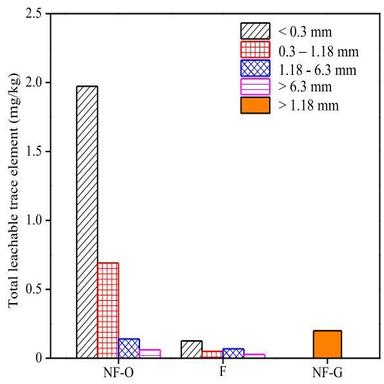
Distribution of the total leaching amount of trace elements in classified IBA.